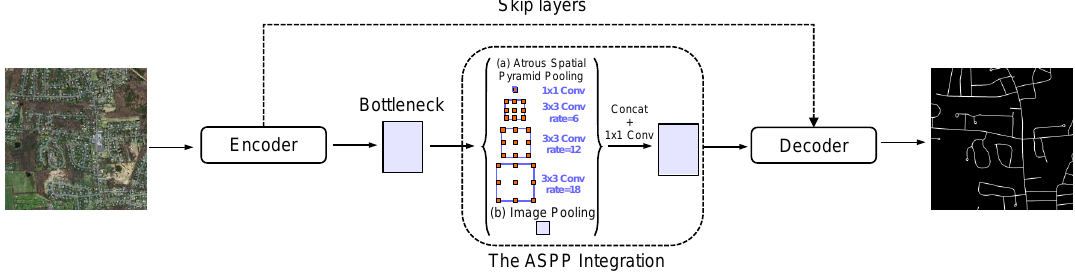
Figure 3. The improved U-net with atrous spatial pyramid pooling (ASPP) integration: The ASPP module is inserted after the bottleneck of the Encoder-Decoder network. This means that the feature map generated by the encoder is processed by using ASPP, and then, the result is fed into the